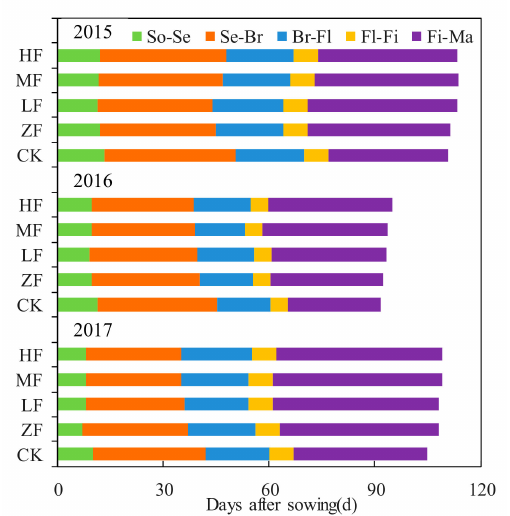
Figure 6. Effects of fertilization application levels on growth period of tartary buckwheat